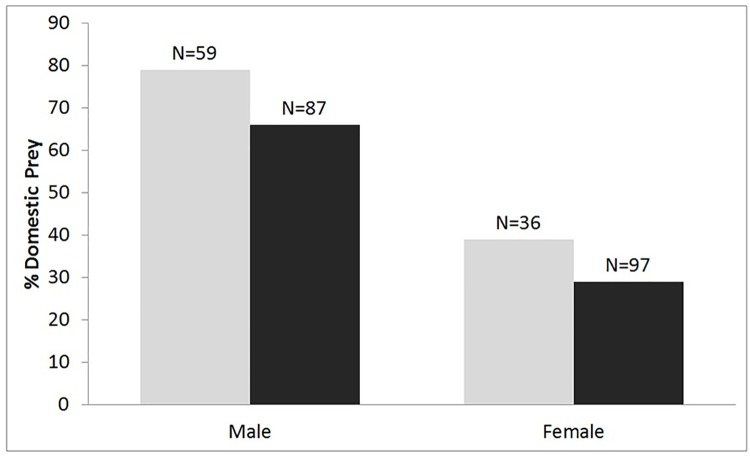
Percentage of domestic animals killed by male and female tigers in the core (black bars) and buffer (grey bars) zone of the PTR between 2009 and 2014.There was a significant interaction between sex * zone (df = 2, p < 0.05), with similar proportions of domestic animals being killed in core and buffer zones by males and females.